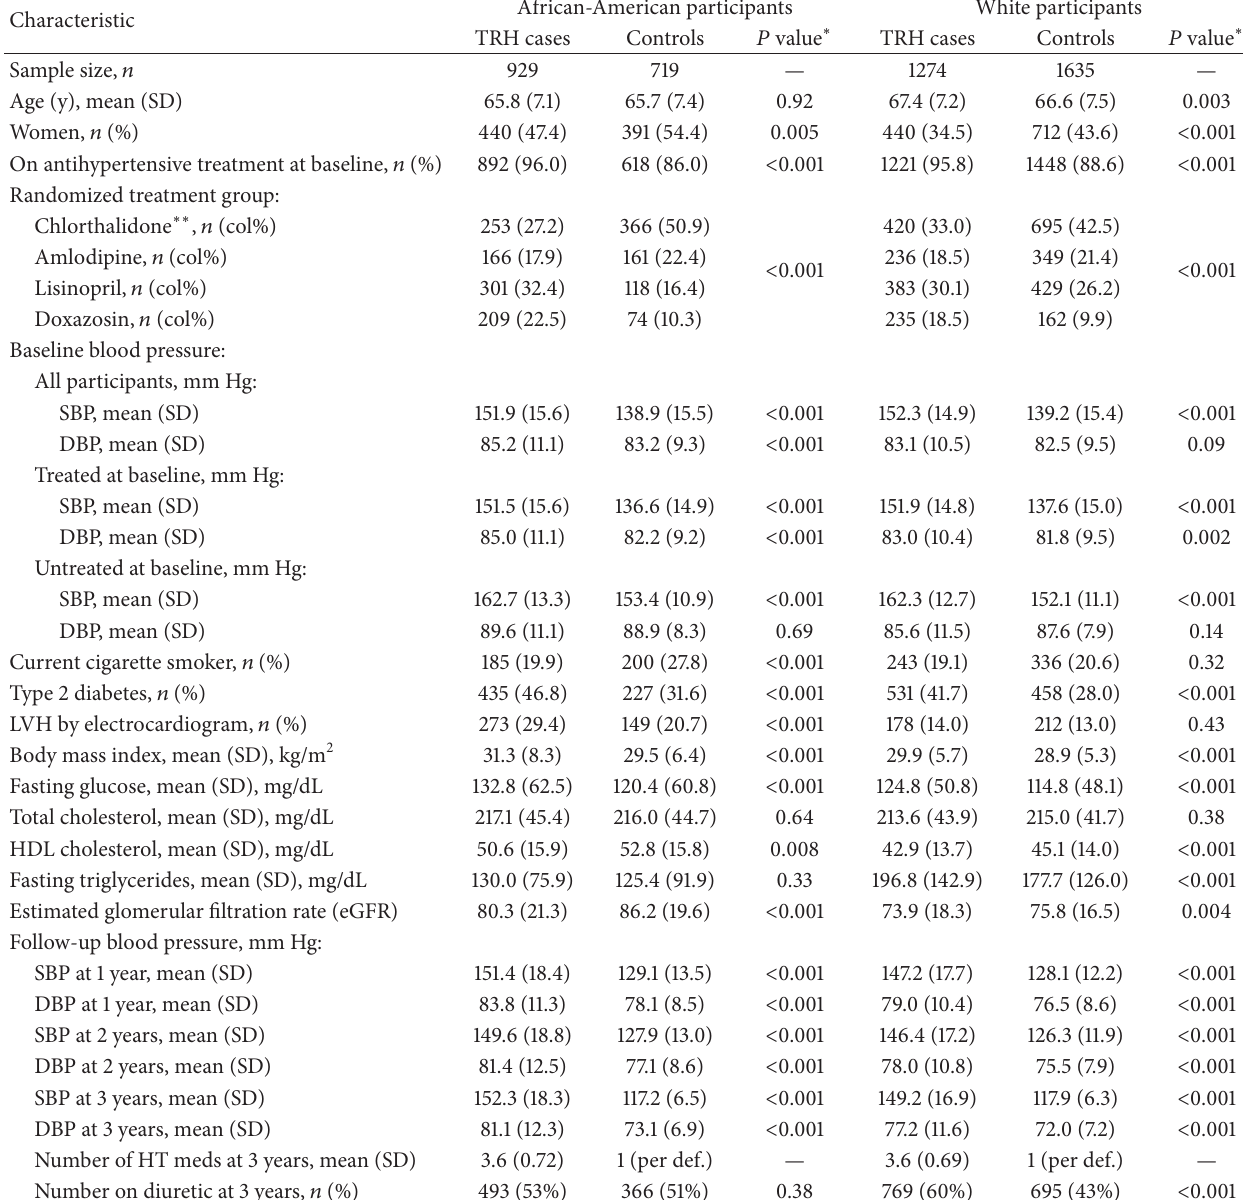
Table 2: Baseline characteristics for African-American and white treatment resistant hypertension cases and